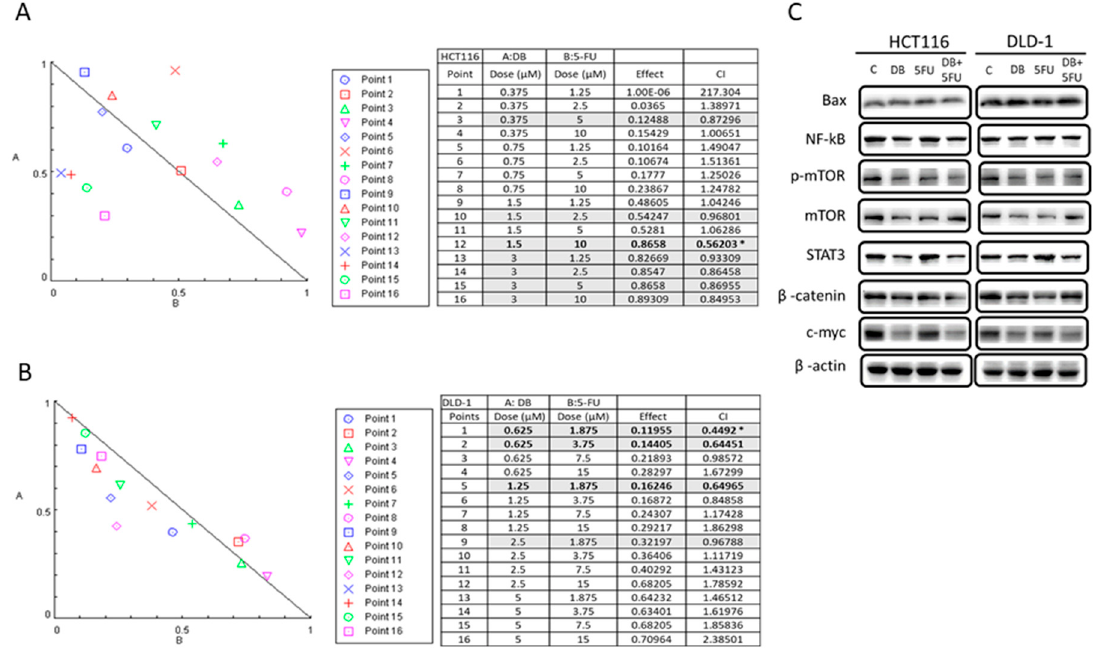
Figure 4. The combination of DB and 5-FU suppressed colon cancer viability. HCT116 ( A ) and DLD-1 ( B ) colon cancer cells were subjected to different concentrations of DB and 5-FU treatment. The combination index (CI) defines synergism (CI < 1), the additive effect (CI = 1), and antagonism (CI > 1). The asterisk depicts the most effective combination of DB and 5-FU. ( C ) Western blot analysis showed that the DB and 5-FU combination led to reduced expression of oncogenic markers (mTOR, STAT3), stemness markers ( β -catenin, c-Myc), and an increased expression of the pro-apoptotic marker,